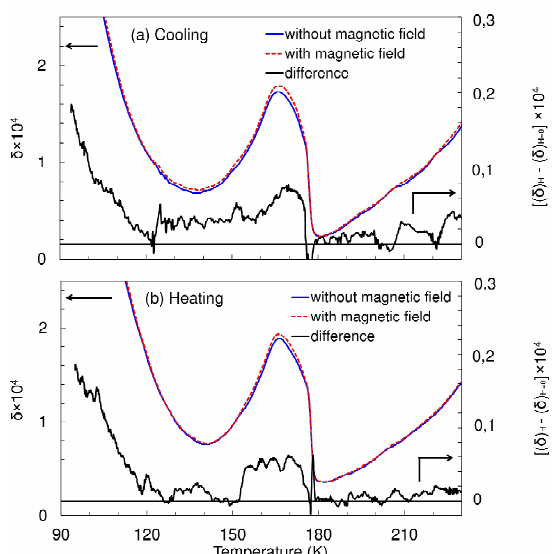
Fig. 4. Temperature spectra of internal friction,  , in thermocycles 250K – 95K – 250K without magnetic field, H = 0, and under magnetic field H = 9 kA/m: (a) cooling, (b) heating. The difference between the spectra with H = 9 kA/m and H = 0 is also shown. Oscillatory strain amplitude  = 10 -5 0